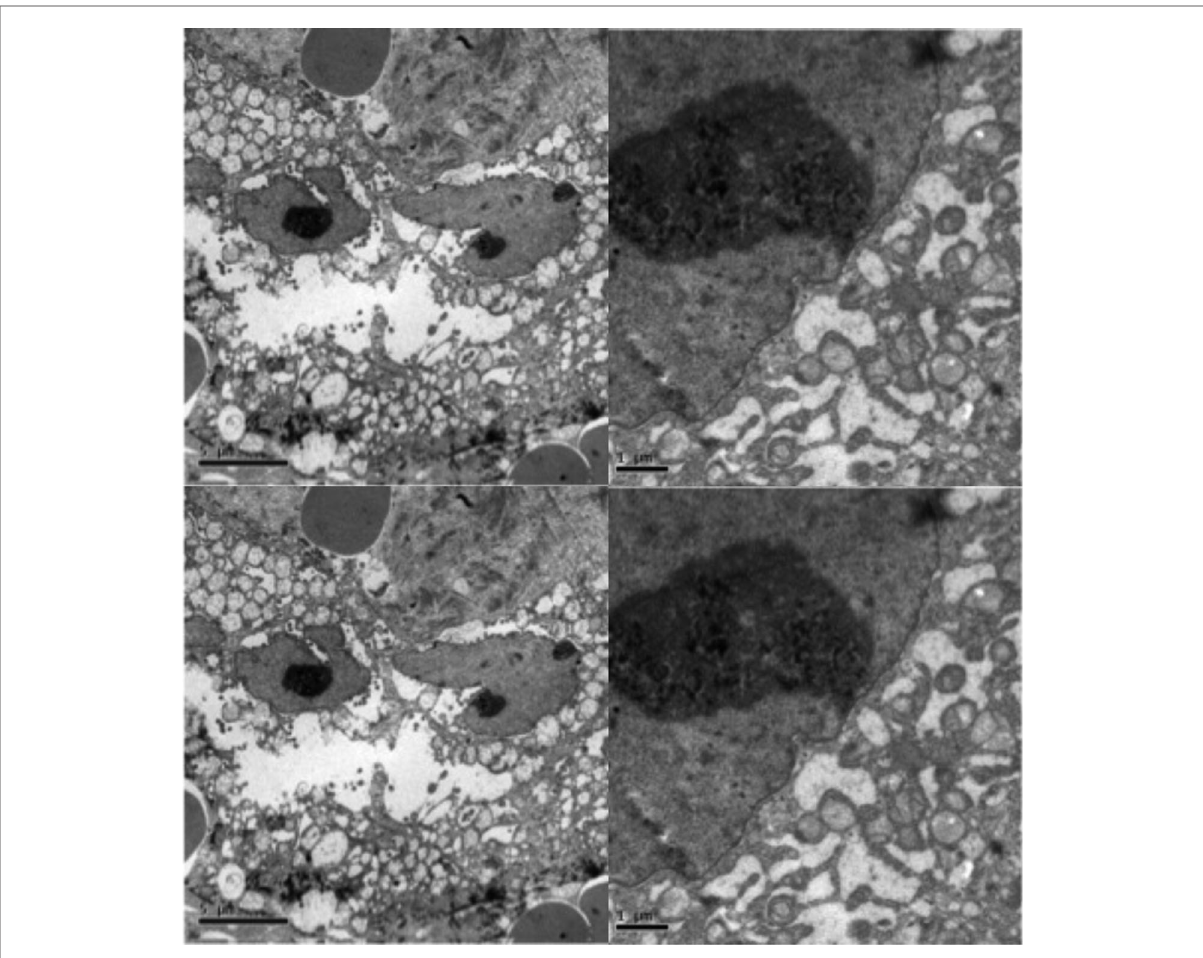
FIGURE 3 Abnormal mitochondrial morphology in a patient with HCC after low-power amplitude-modulated radiofrequency electromagnetic fi eld exposure. Tissue sections at ultrastructural level of the patient given in Figure 2 are shown. Left: HCC cell with disorganized cytoplasmic organelles and diffuse electron-lucent dilation of reticulum, probably re fl ecting water accumulation, and mitochondria present in dilated regions. Right: HCC cell with hydropic dilated reticulum around isolated and atypical mitochondria showing morphological changes characterized by disorganized crista and swelling of the matrix. HCC, hepatocellular